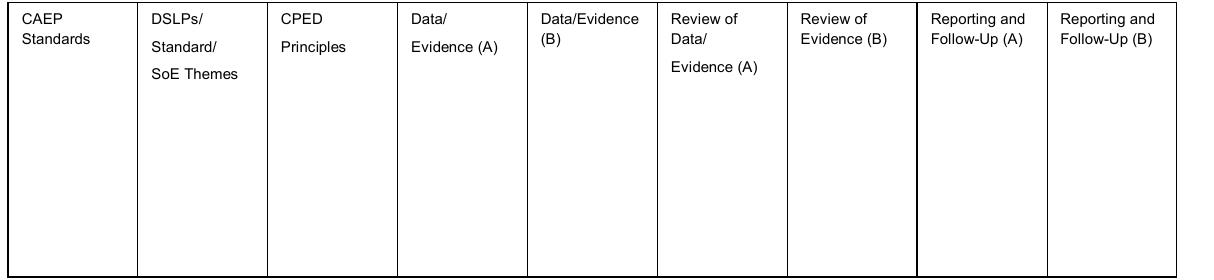
Table 5. Program Learning Outcomes/Keystones with each Standard Set Program Learning Outcomes/Keystones